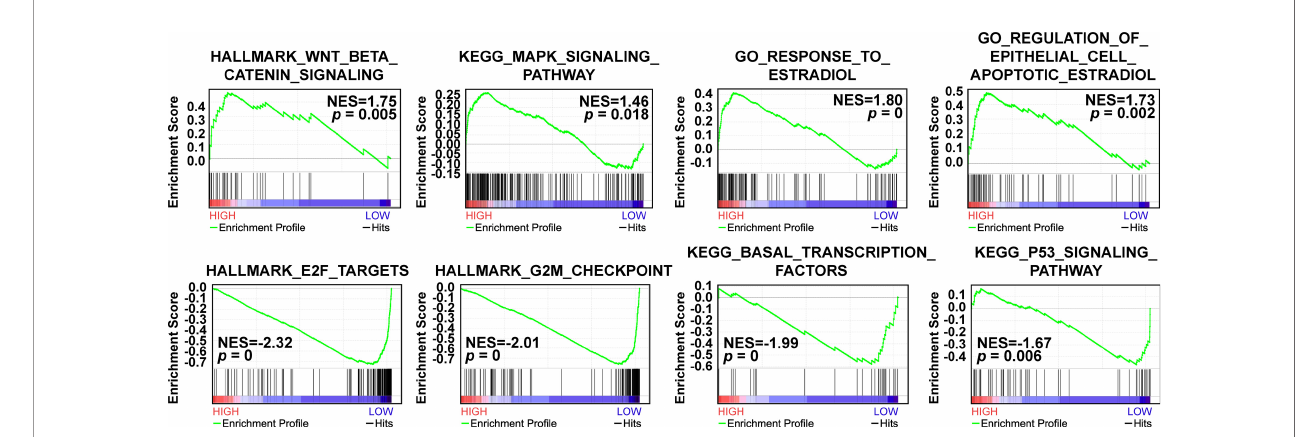
FIGURE 7 | GSEA analysis of altered CAVIN2 expression levels and relevant